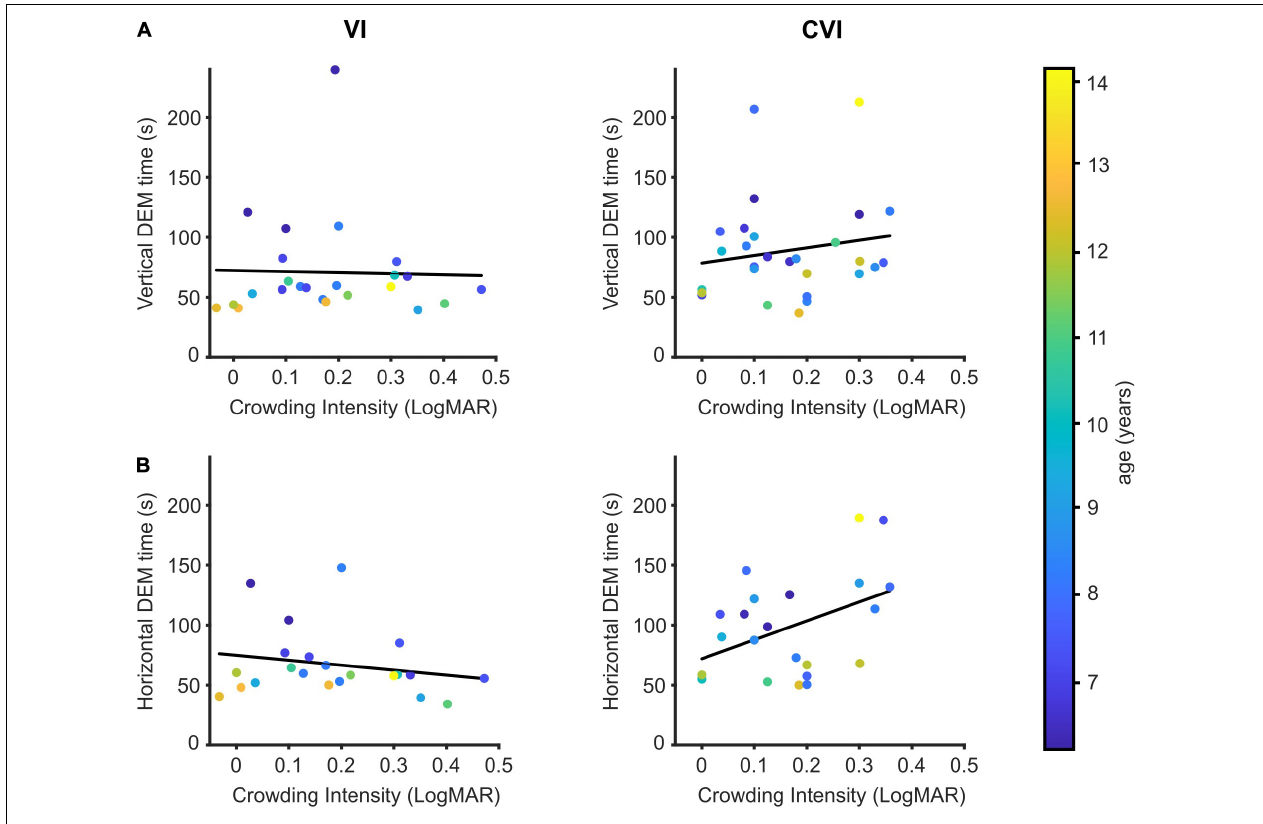
FIGURE 3 | DEM performance in relation to crowding intensity. (A) Crowding intensity compared to the time needed to perform the vertical DEM for children with VI (left) and children with CVI (right). Regression lines in black. Data points are color-coded by age of the child. (B) Same as (A) , but for the horizontal